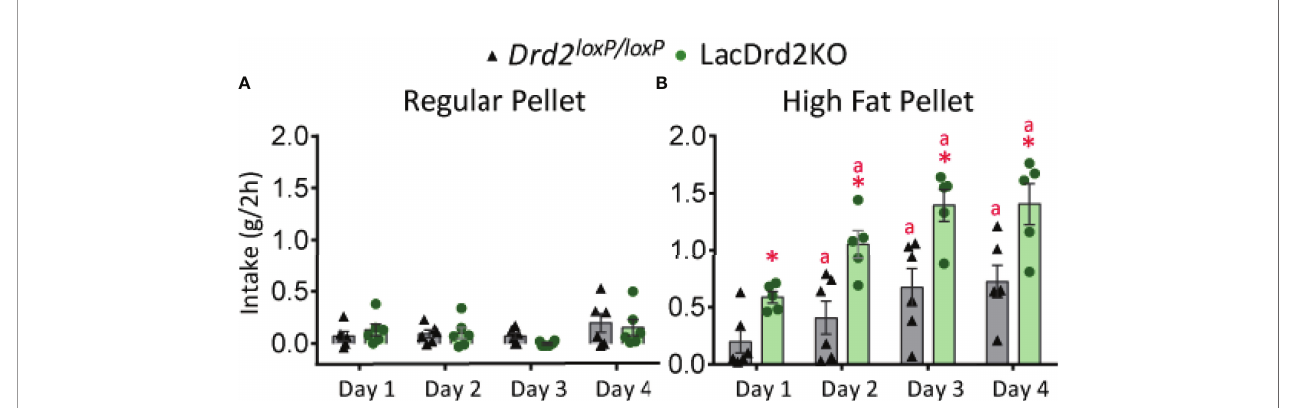
FIGURE 1 | LacDrd2KO female mice have increased binge eating behavior. Characterization of binge-eating behavior in 5-month old lacDrd2KO and Drd2 loxP/loxP female mice. (A) Regular pellet intake in grams during 2 hours for 4 consecutive days, n= 6 and 6 for Drd2 loxP/loxP and lacDrd2KO mice, respectively. (B) High Fat pellet intake in grams during 2 hours for 4 consecutive days, n= 6 and 5 for Drd2loxP /loxP and lacDrd2KO mice, respectively. Repeated measures TWO ANOVA; “ a ” P ≤ 0.05 vs. genotype-matched HF mice on day 1; * P ≤ 0.05 vs. Drd2 loxP/loxP HF- fed, day-matched